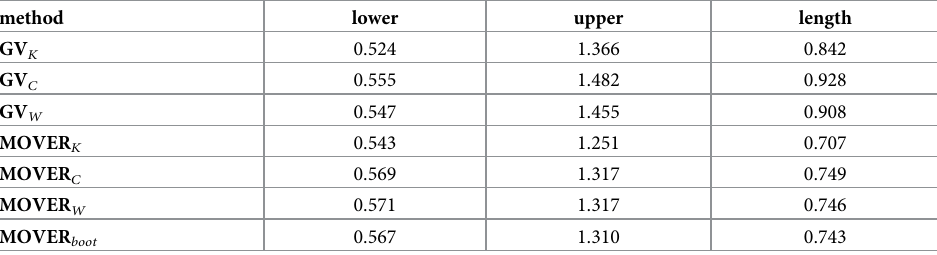
Table 6. Estimated confidence intervals and lengths for the common mean for Chloride concentration (in mg/ litre) in